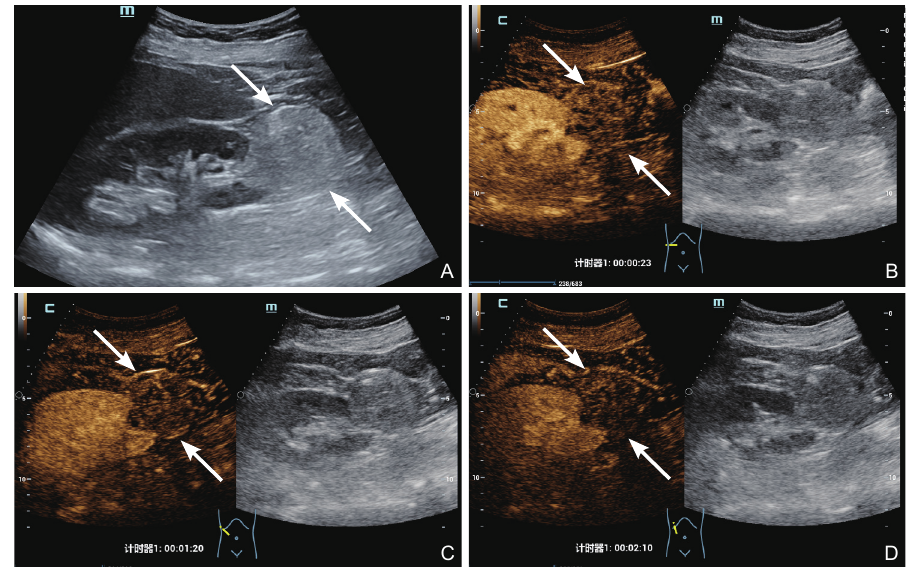
Figure 6 In a 54-year-old female, a hyperechoic mass of 4.9 × 4.3 cm was seen in the lower pole of the right kidney, with clear boundary and regular shape, and part of it protrudes out of the renal capsule (A). After intravenous injection of ultrasound contrast agent SonoVue, homogenous iso- and hypo- enhancement seen in the cortical (B) and the medullary (C) phases, and very low enhancement seen at the delayed phase (D).